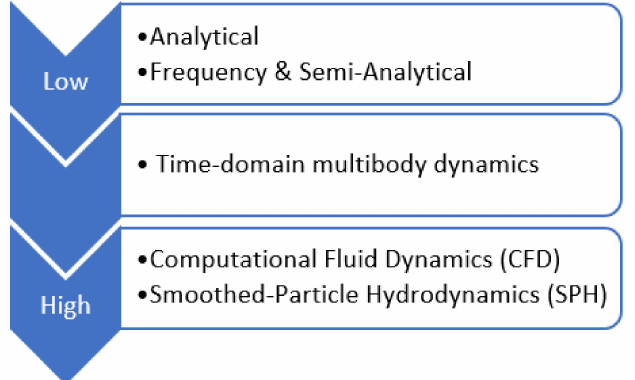
Figure 1. Wave Energy Converter numerical modelling fidelity